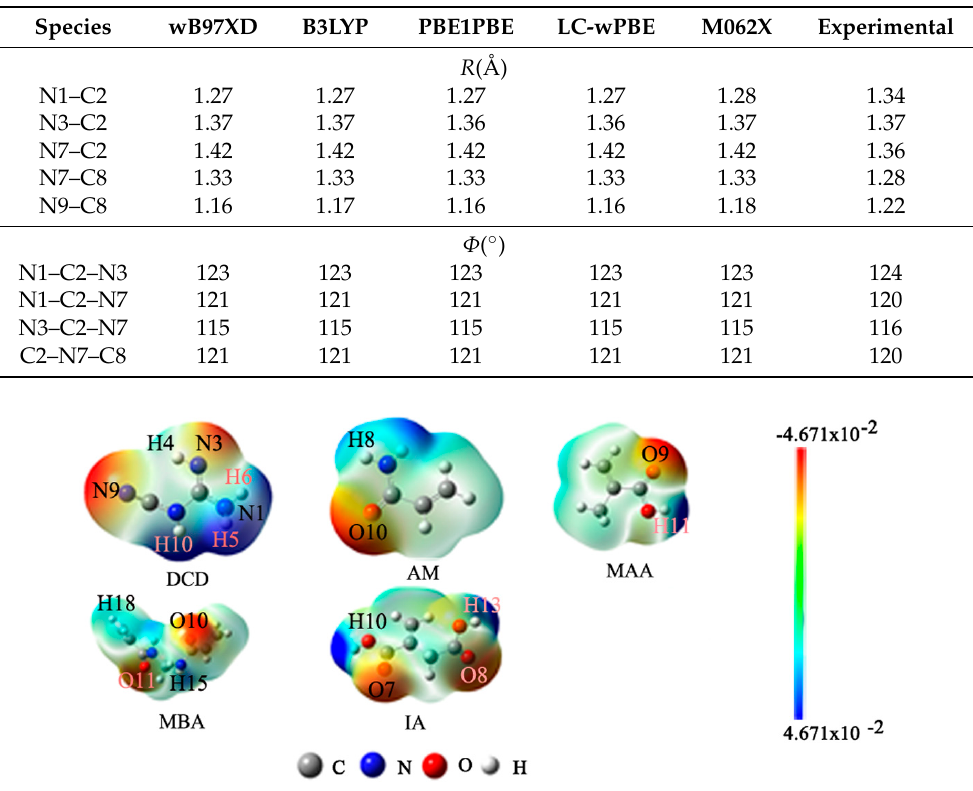
Figure 2. MEP populations of DCD, AM, MAA, MBA, and